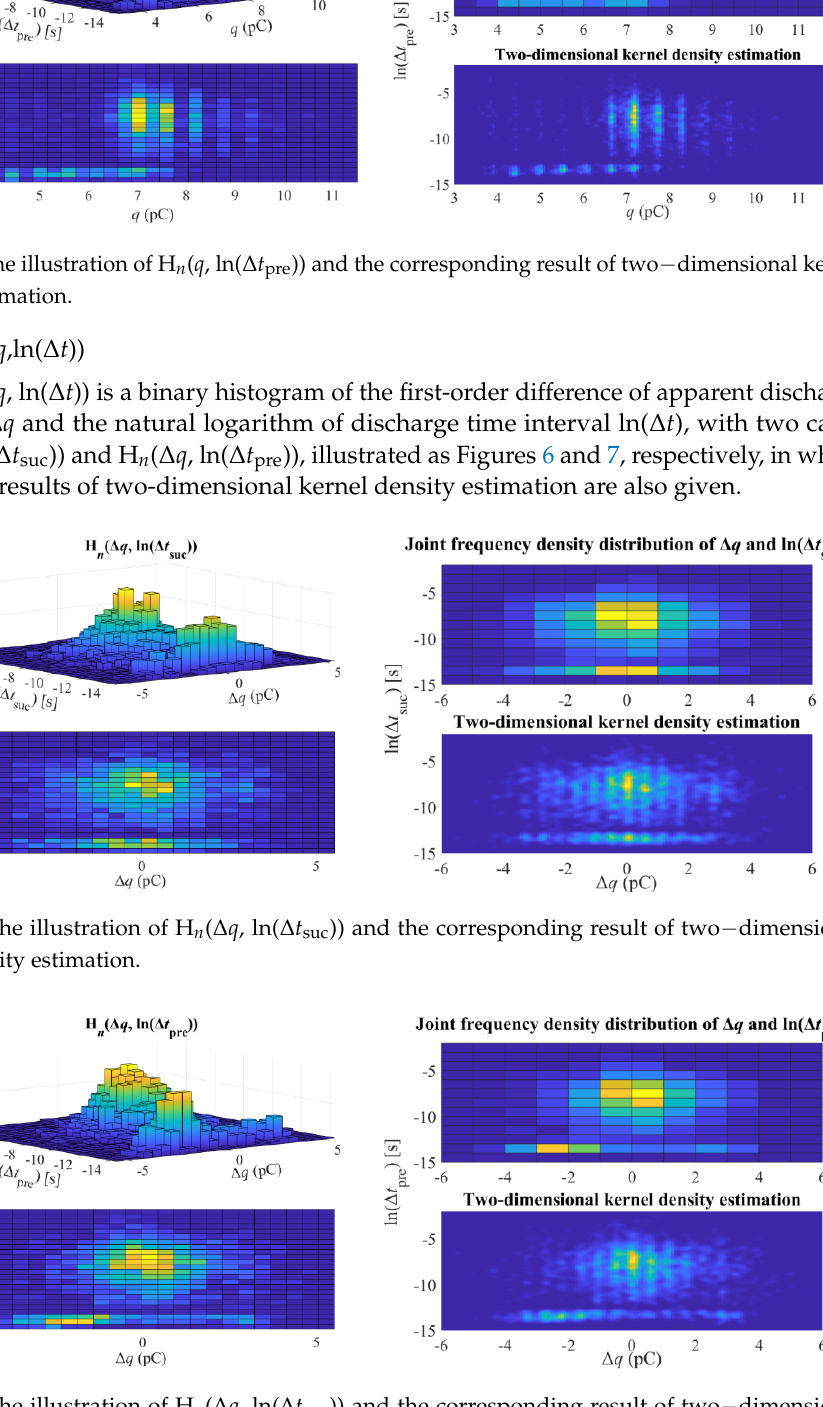
Figure 7. The illustration of H n ( Δ q , ln( Δ t pre )) and the corresponding result of two − dimensional kernel density estimation. L. H n ( Δ q , ln| Δ ( Δ t )|)